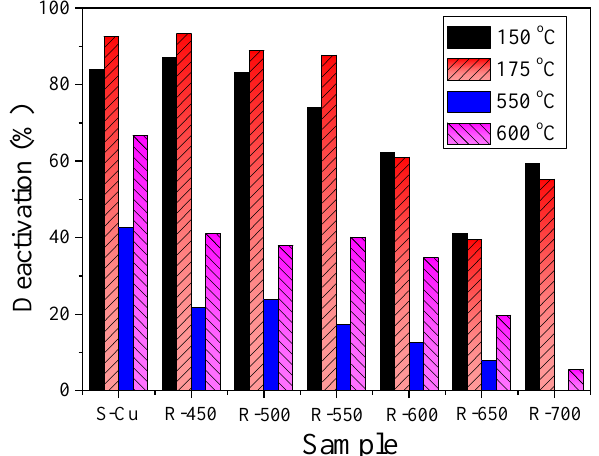
Figure 10. Selective catalytic reduction (SCR) catalytic performance of Cu-SSZ-13 catalysts in fresh, sulfated and regenerated states.